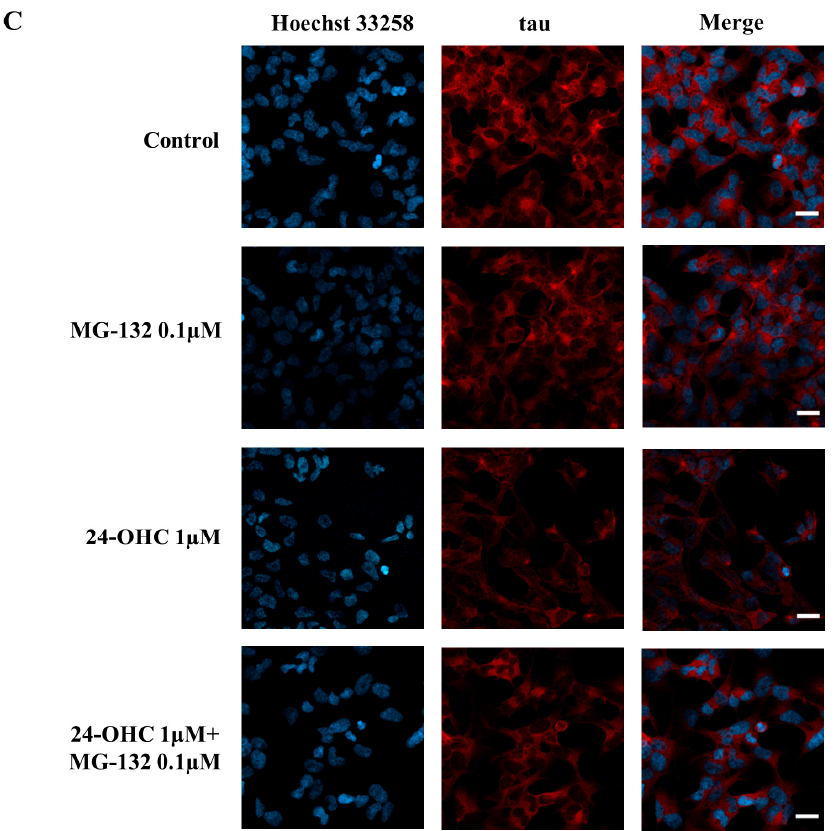
Figure 6. Effect of 24-OHC on Nrf2-dependent proteasome activity and on tau proteasomal degradation. ( A ) Proteasomal chymotrypsin-like activity was analyzed using a commercial kit. Cells were transfected for 6 h with Nrf2 or scrambled siRNA and then treated with 24-OHC (1 µ M) for 24 h. The histograms represent mean values ± SD of three experiments and expressed as percentage of control value. *** p < 0.001 vs. control; ### p < 0.001 vs. 24-OHC. ( B ) Tau protein levels were analyzed by Western blotting in 24-OHC-treated cells for 24 h and co-treated or not with 0.1 µ M MG-132, an inhibitor of proteasome activity. Representative blots are shown. The histograms represent mean values ± SD of three experiments. Tau densitometric measurements were normalized against the corresponding β -actin levels and expressed as percentage of control value. * p < 0.05 vs. control; ## p < 0.01 vs. 24-OHC; § p < 0.05 vs. MG-132. ( C ) After 24-OHC (1 µ M) cell treatment (24 h), with or without MG-132 (0.1 µ M), tau protein levels were detected by confocal laser microscopy equipped with a Plan-Apochromat 63x/1.40 DIC oil immersion objective, scale bar 20 µ m. Nuclei were stained with Hoechst 33258 (exciting max/emission max: 352 nm/461 nm) and tau was revealed by a fluorescent probe (Alexa Fluor 594, exciting max/emission max: 590 nm/617 nm). The images are representative of two